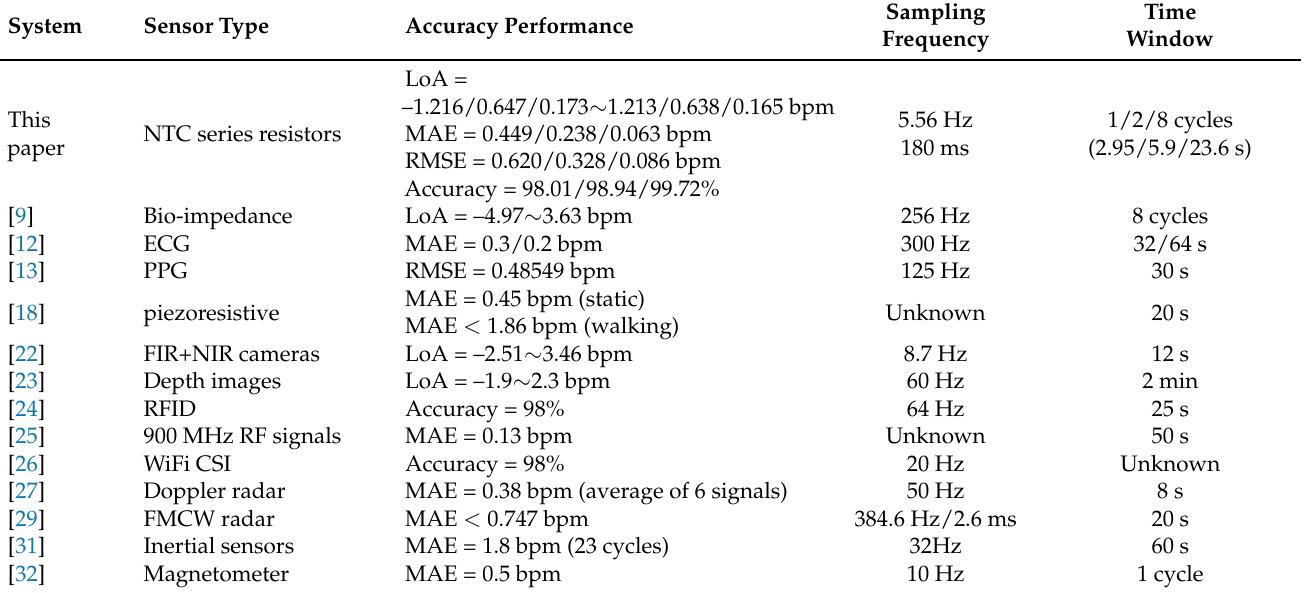
Table 1. Performance compared to other sensors.